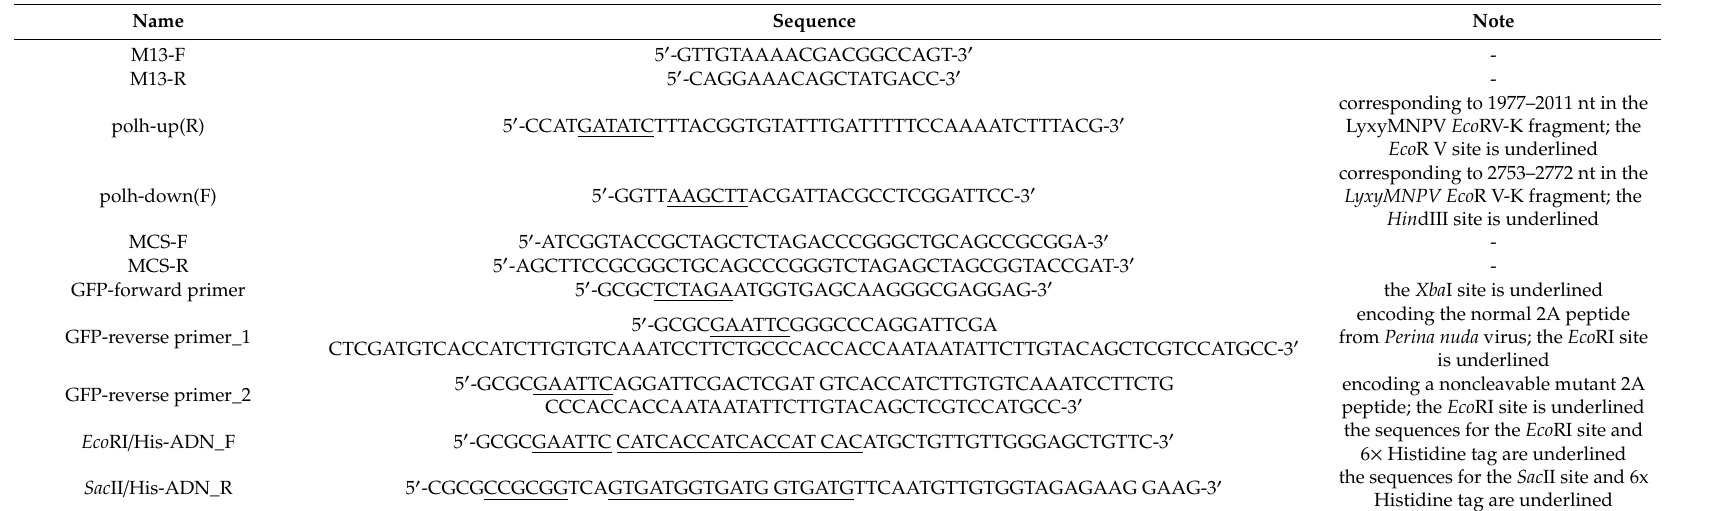
Table 1. The primers used in this